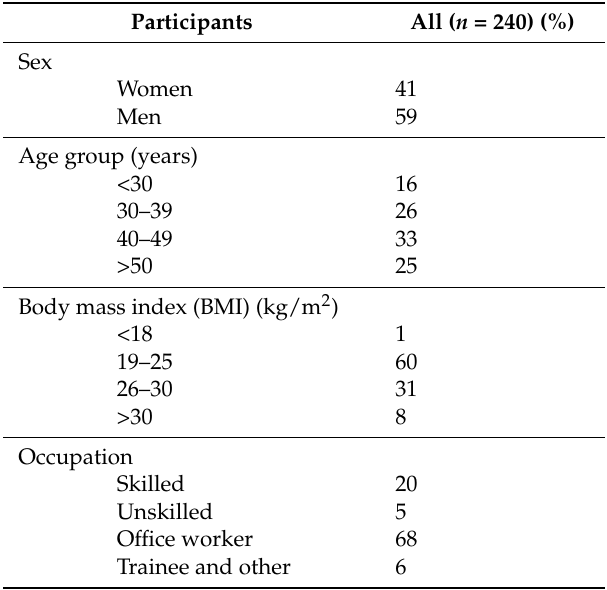
Table 1. Characteristics of participants.